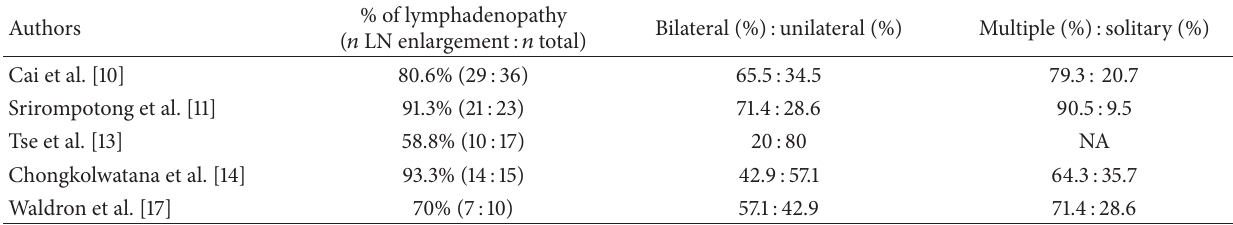
Table 2: Clinical characters of cervical lymphadenopathy in NPTB.